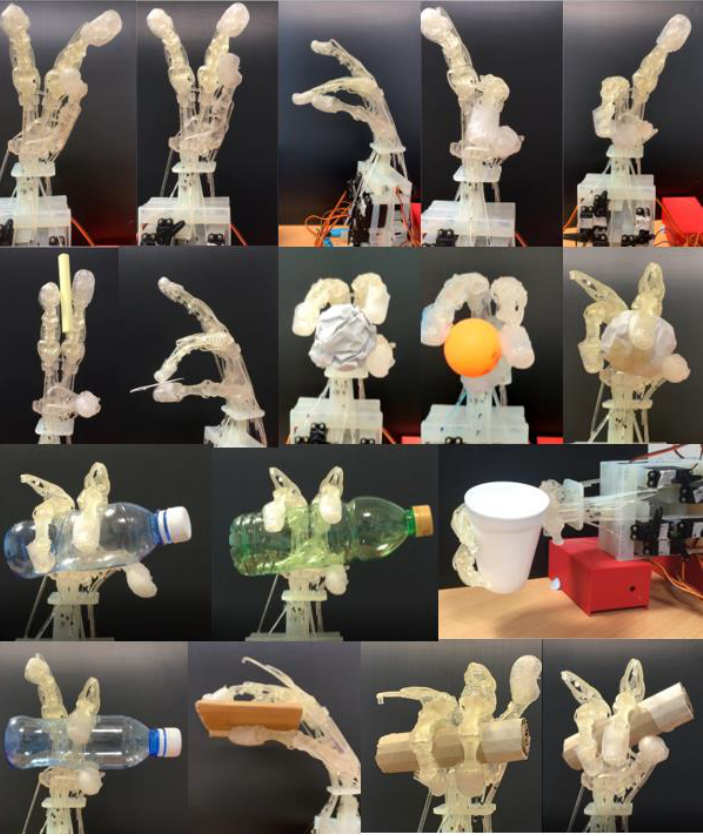
Figure 10. Tasks. Row 1 presents the performance of five Kapandji tests. Rows 2–4 show the robotic hand performing 12 gestures from the grasping taxonomy.